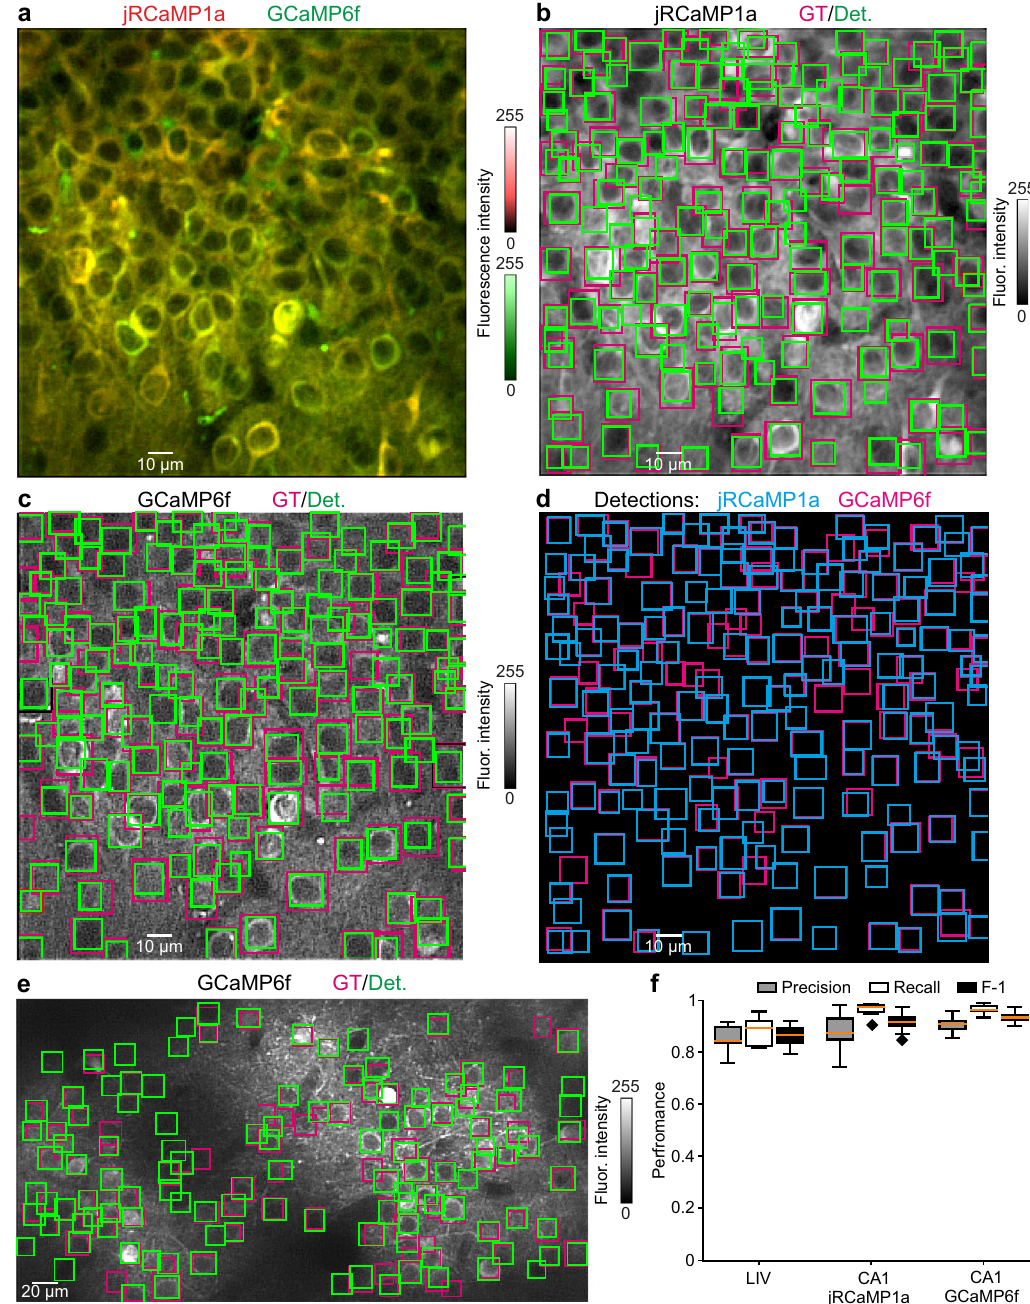
Fig. 2 CITE-On of fl ine cell detection performance. a Representative fl uorescence median projection showing jRCaMP1a (red) and GCaMP6f (green) expressing CA1 neurons. b Ground truth (GT, magenta) and CITE-On detections (Det, green) for the jRCaMP1a channel of the image shown in a . c Same as in (b), but for the GCaMP6f channel. d Superposition of CITE-On detections on jRCaMP1a (cyan) and GCaMP6f (magenta) channels. e Representative median projection from the LIV dataset with GT (magenta) and CITE-On detections (green). f Boxplots showing performance as Precision (gray), Recall (white), and F-1 score (black) obtained with the of fl ine CITE-On pipeline on the validation t-series of the LIV ( N = 13), CA1 jRCaMP1a ( N = 12), and CA1 GCaMP6f ( N = 12) datasets. The orange line in all boxplots indicates the median, the bounds of the boxes represent the 75th and 25th percentiles (i.e., the interquartile range (IQR)), and the whiskers correspond to the highest value or lowest value of the distribution. If the lowest or highest values are outliers (i.e., >1.5 *IQR from the bounds of the boxes) the whiskers correspond to 1.5 *IQR. Outliers are represented as black